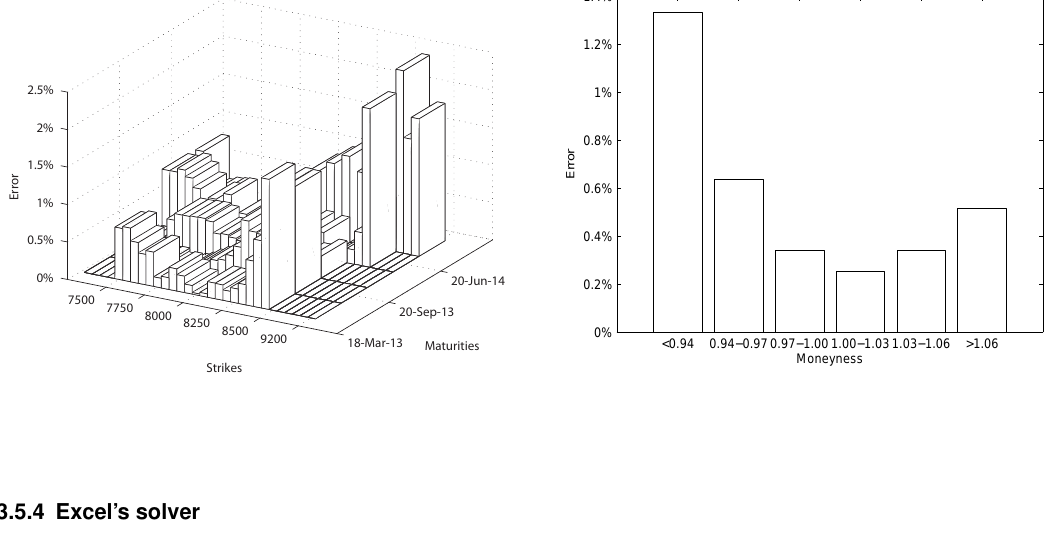
Fig. 4. Results for lsqnonlin . The left picture portrays the absolute relative errors. The right picture shows the average absolute relative errors in terms of moneyness. Initial values were provided by deterministic